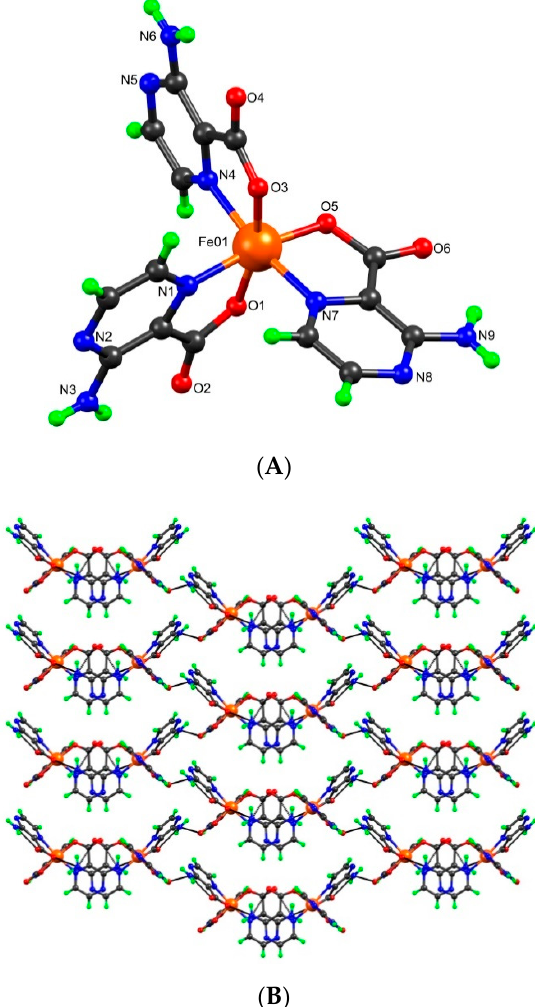
Figure 1. ( A ) Ball-and-stick representation of 1 with partial atom numbering scheme. ( B ) Its hydrogen- bonded 2D network.